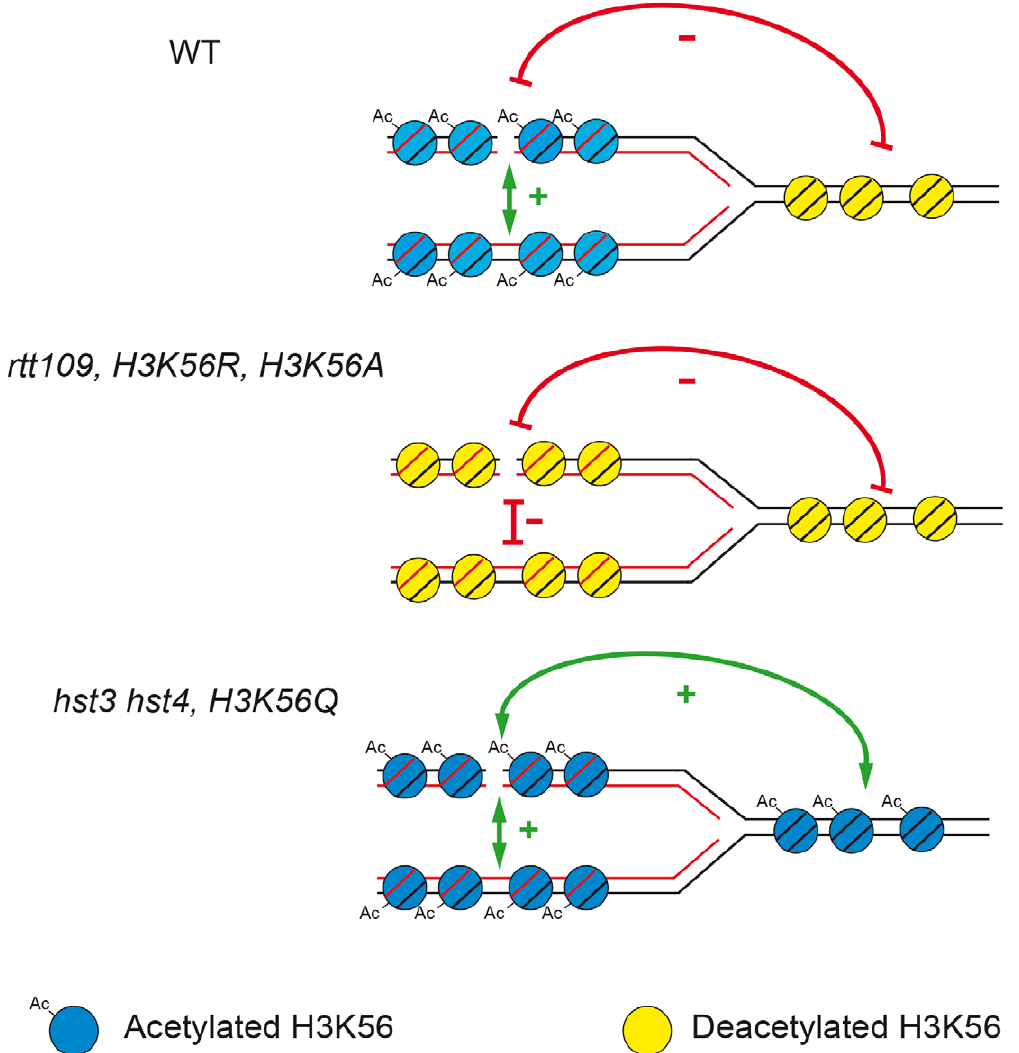
Figure 9. Model to explain how the state of acetylation/deacetylation of H3K56 influences SCR. Newly incorporated Histone H3 in the newly born sister-chromatids are acetylated, whereas the unreplicated DNA contains deacetylated histone H3. In the absence of K56 acetylation or when all histones H3 are acetylated, the recombination apparatus does not efficiently recognize the sister and the SCR preference is lost.